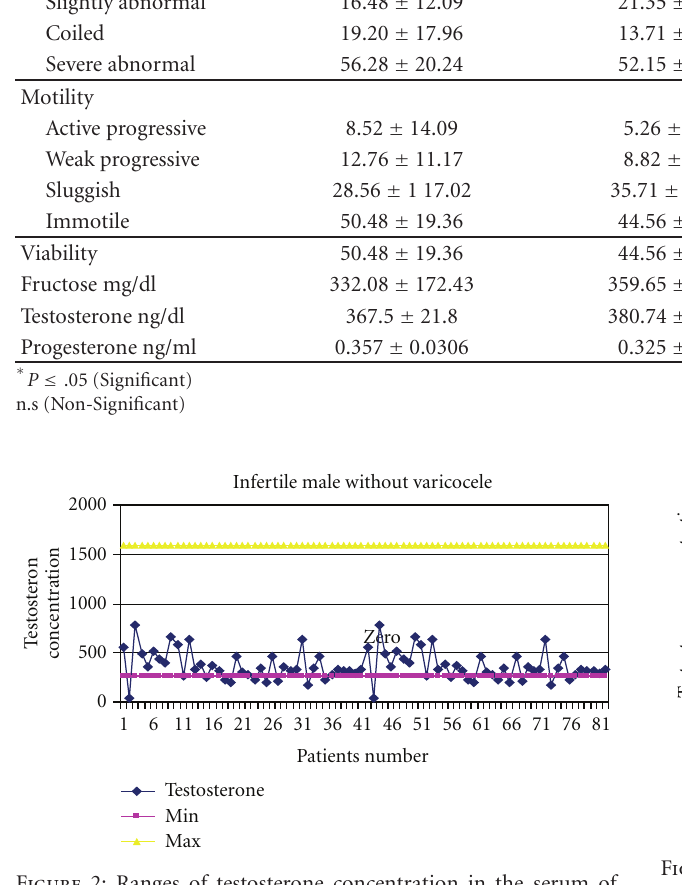
Figure 2: Ranges of testosterone concentration in the serum of infertile males without varicocele.